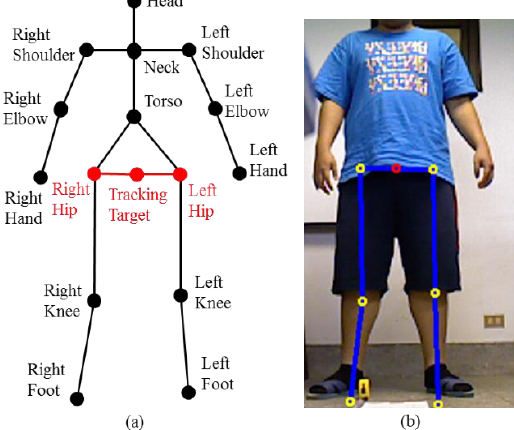
Figure 7. ( a ) Feature points of skeleton; ( b ) intruder detection results.